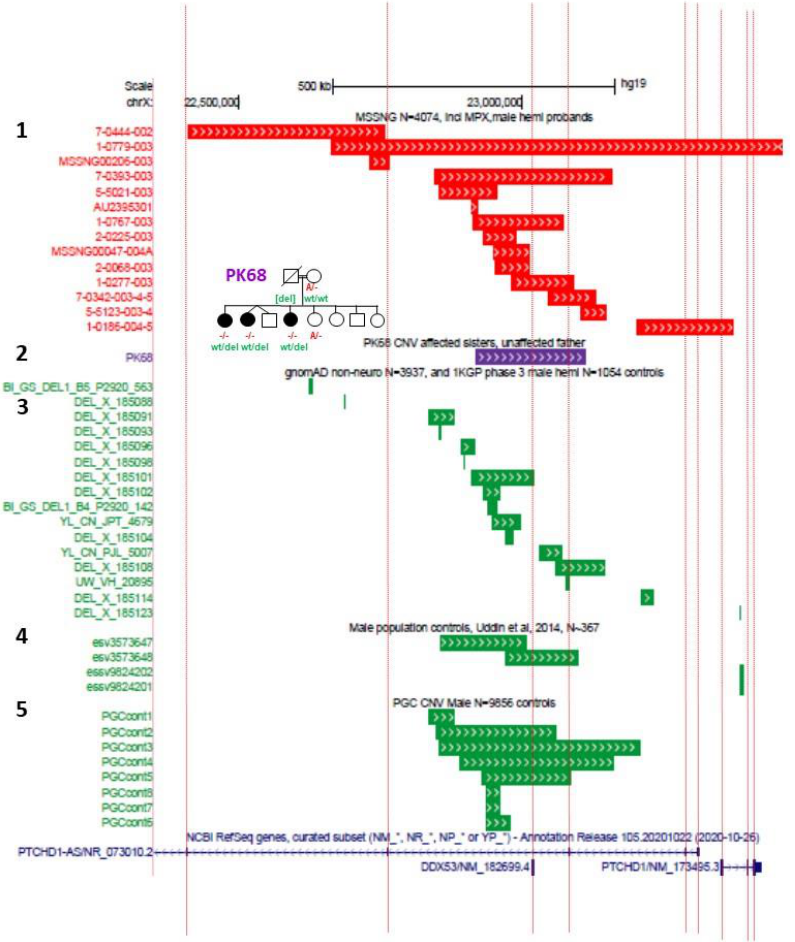
Figure 2. Male loss CNVs across ASD and control populations: 1. Loss CNVs (high-quality rare calls) in male affected individuals from the MSSNG ASD whole genome sequencing project (N = 4074); 2.